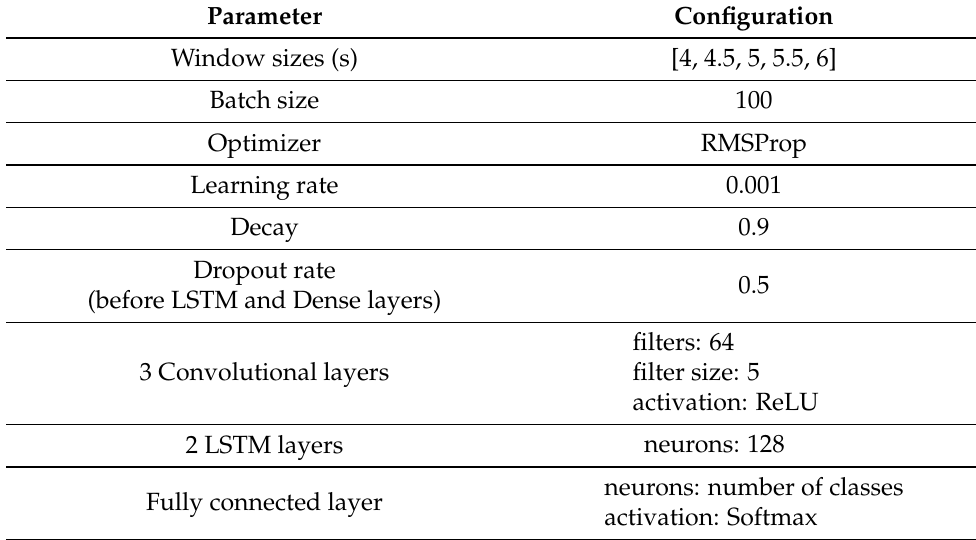
Table A7. SKODA DTE ConvLSTM model